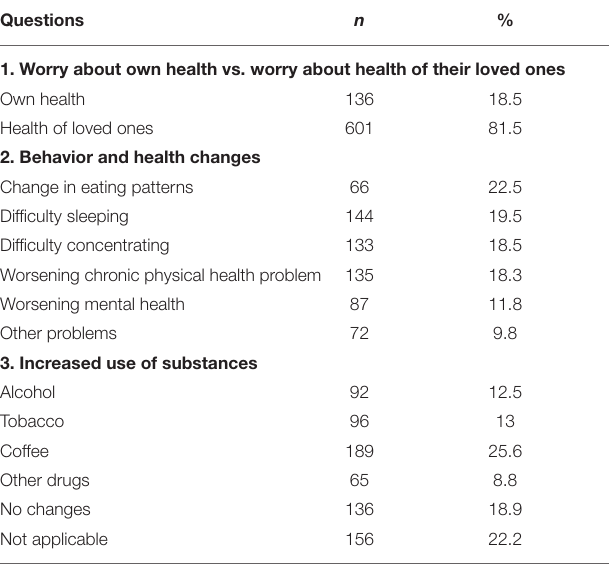
TABLE 4 | Participants’ responses to three questions measuring health worry, behavior, and health changes, and increased use of some substances.